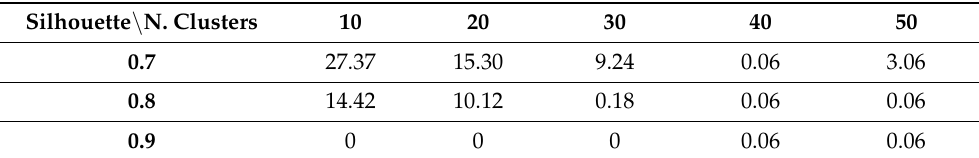
Table 18. Clustering performance in terms of silhouettes using the reduced dataset with SPQR applied to normalized data.